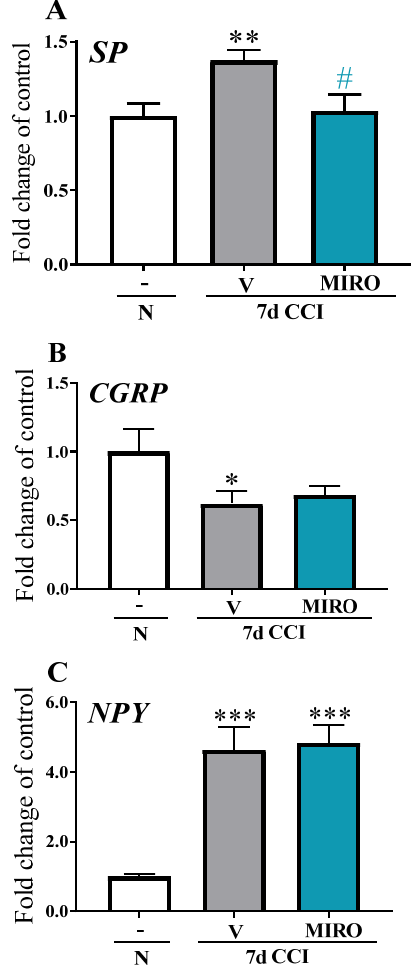
Figure 6. Effect of repeated intraperitoneal ( i.p. ) administration of mirogabalin (MIRO; 20 mg/kg) on substance P ( A ), CGRP ( B ), and neuropeptide Y ( C ) mRNA levels in the spinal cord on day 7 post-CCI